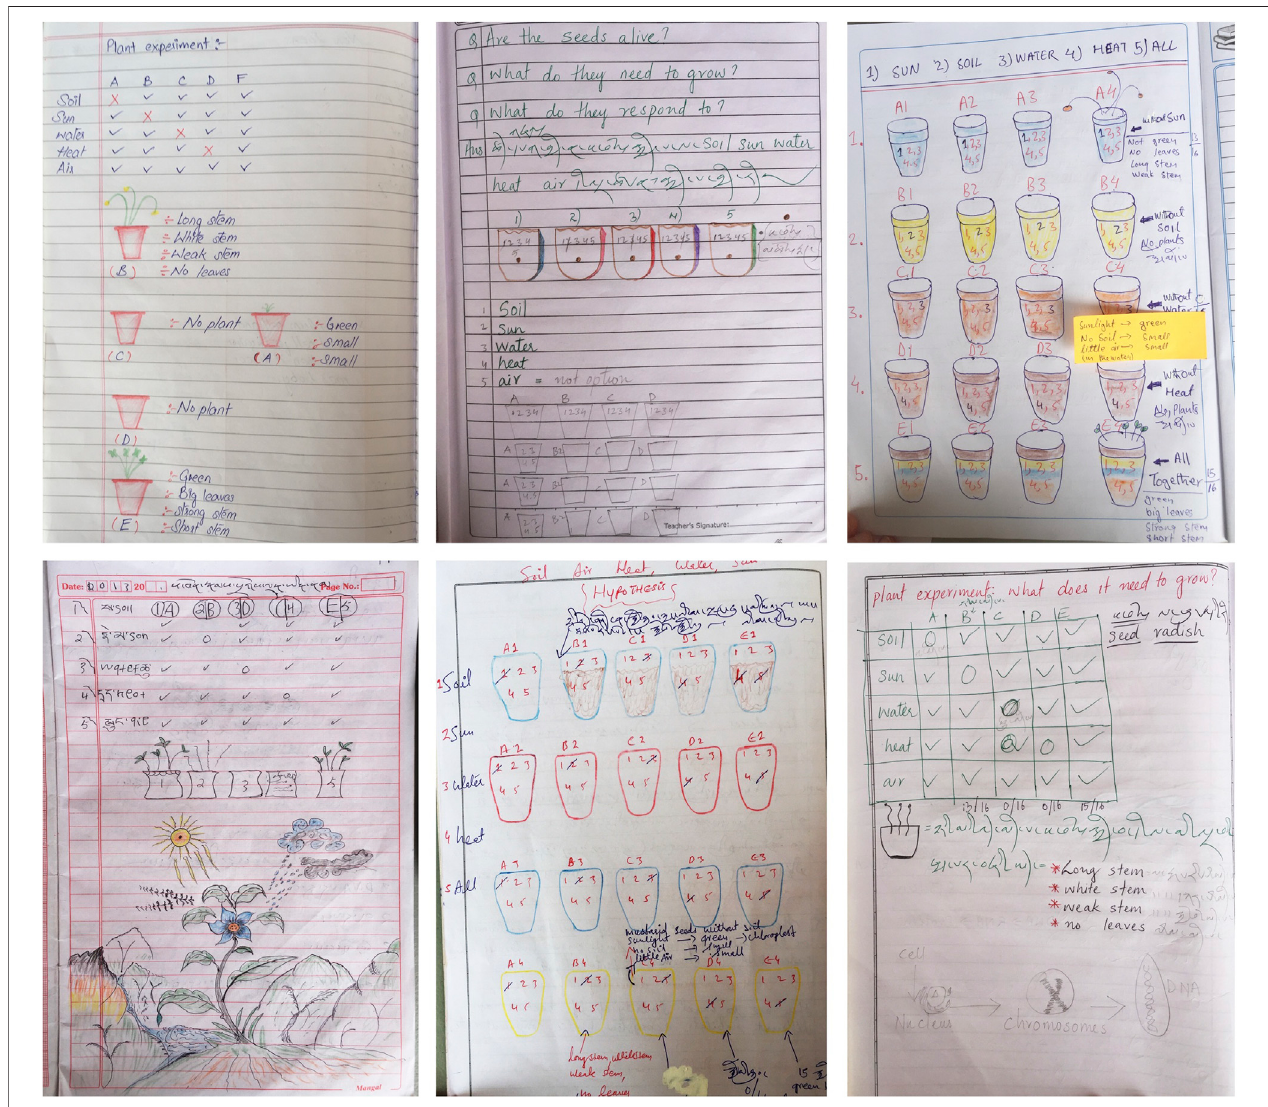
FIGURE2| Adatavisualizationactivityfromsixstudent ’ snotebooks,representingaclassstudyofvariablesaffectingradishseedgerminationandgrowth.Student matrices were personally meaningful and distinct.